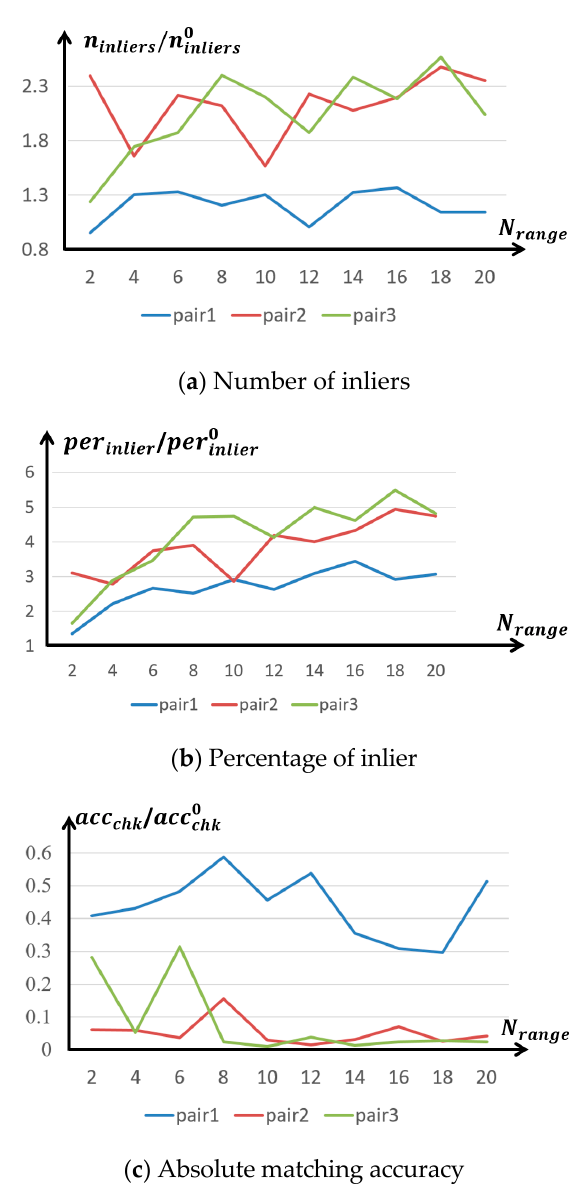
Figure 4. The trend of matching accuracy with various N range on the Fayu temple dataset. ( a ) shows the inlier number trend with increasing N range ; ( b ) shows inlier percentage trends with increasing N range ; ( c ) shows the absolute matching accuracy trends with increasing N range .